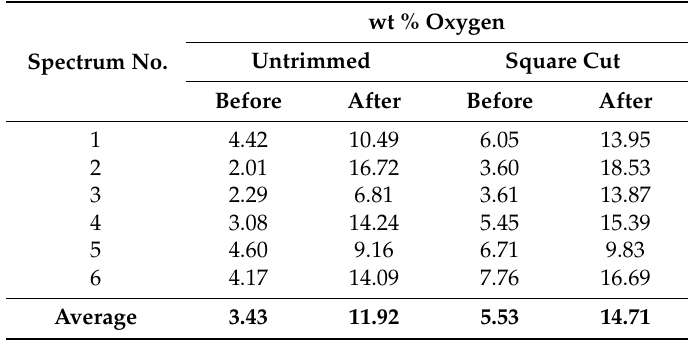
Table 1. EDS chemical analysis for oxygen content of untrimmed and square cut trimmed shunt resistor samples before and after the high temperature stability test Spectrum No.